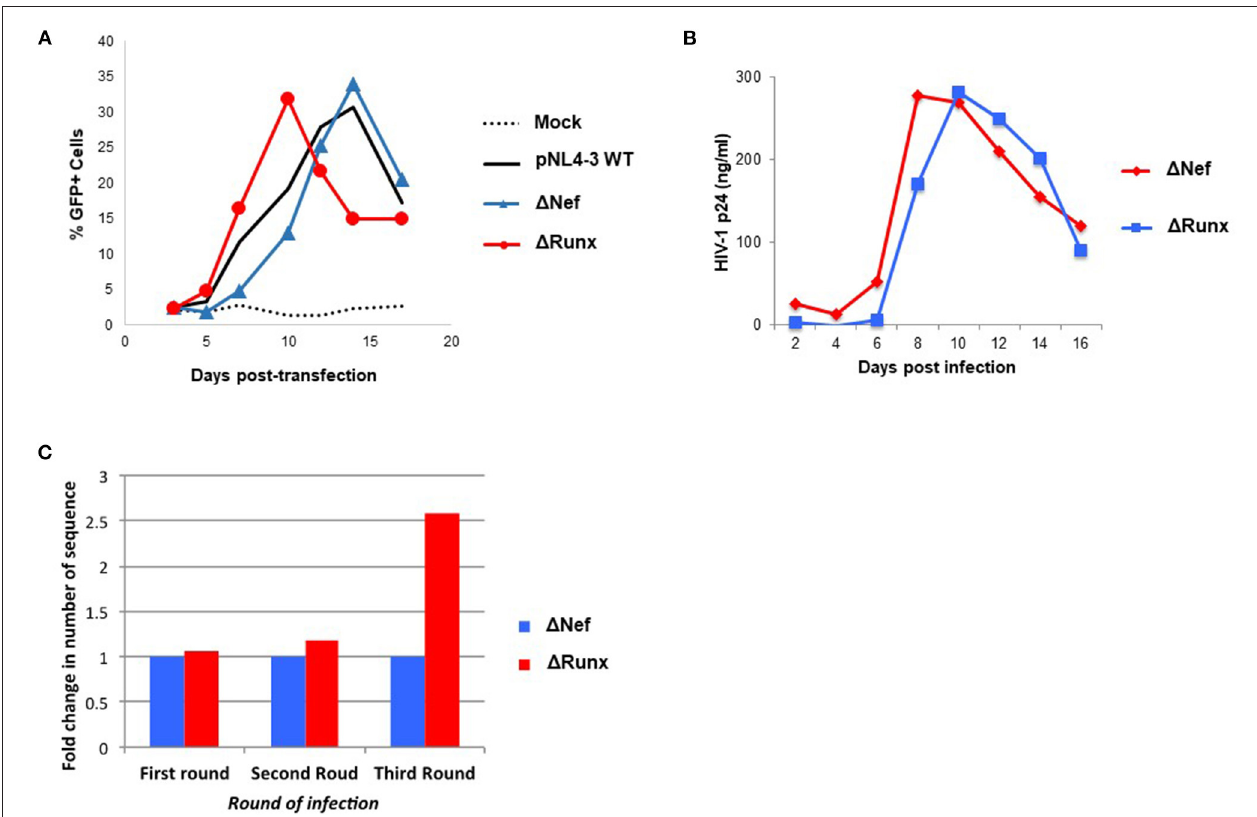
FIGURE 5 | Deletion of the RUNX1 binding site from the HIV-1 LTR enhances replication kinetics relative to WT. (A) J-LTR-GFP cells were transfected with pNL4-3 WT, 1 Nef, 1 RUNX molecular clones and replication was monitored by measuring the percentage of GFP positive cells in the culture every 2-3 days post-transfection. (B) Jurkat cells were infected with equal nanogram quantities of viral stocks for 1 Nef or 1 RUNX and replication was followed over time by p24 ELISA. (C) A competition assay was performed where J-LTR-GFP were infected with equal infectious units of the two viruses and supernatant from the peak of infection was used to infect a new round of cells. Extracellular RNA isolated from the peak of each round of infection was amplified using primers against the LTR and sequenced to be able to determine the relative abundance of each virus in each round of